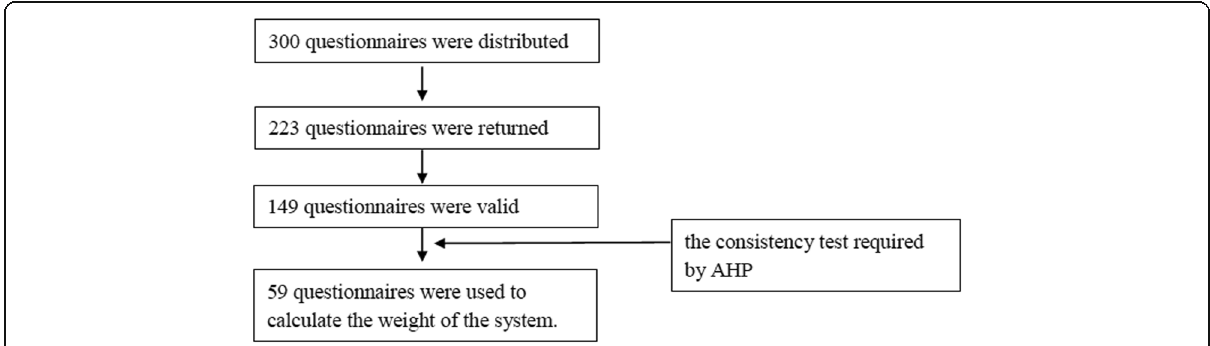
Fig. 2 System Questionnaires. AHP theory requires matrix consistency testing to exclude logic errors in questionnaires. This matrix consistency testing was performed, which 59 questionnaires passed and used to calculate the weight of the system. This matrix consistency testing which